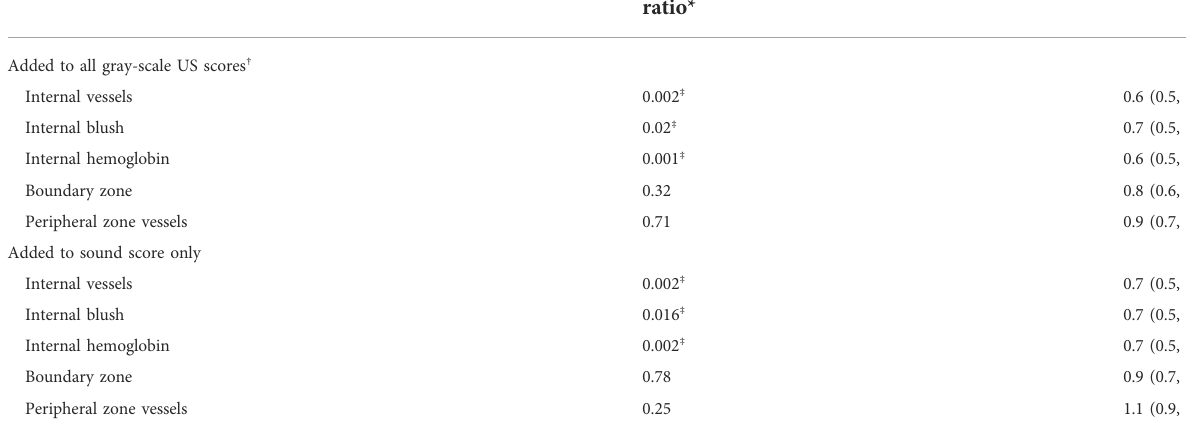
TABLE 1 Multinomial Logistic Regression Analysis to Show Incremental Bene fi t of Each Optoacoustic US Feature to Distinguish Luminal Cancers (A and B) from Triple-negative and HER2+ Subtypes in 532 Invasive Cancers (reproduced from (Dogan et al., 2019) with permission from The Radiological Society of North